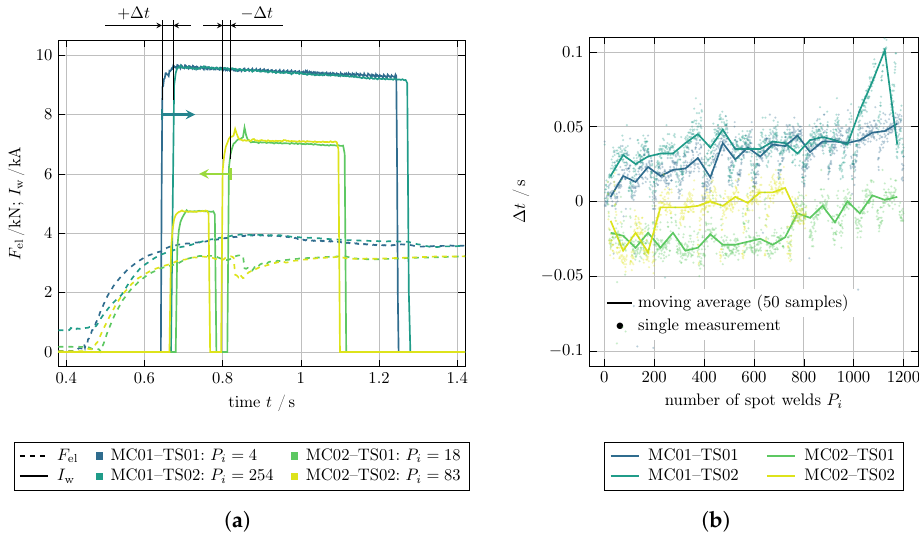
Figure 22. ( a ) ∆ t as shift of WB due to electrode length change in detail and ( b ) over number of spot